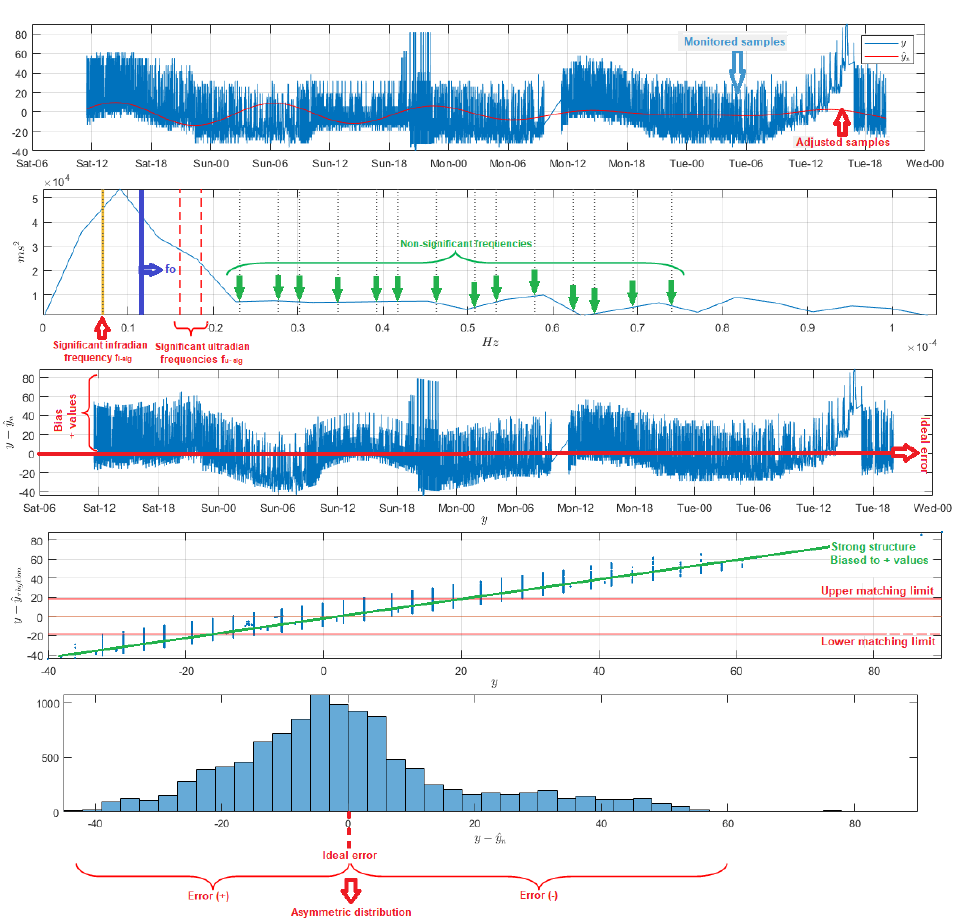
Figure A1. Modeling the CO 2 signal at Sensor Node 4 of DigiMesh network ( Ord = 0, and Reg = 0). From top to bottom: Rhythmometric analysis, frequency components in the FFT, residual time evolution, Bland–Altman diagram, and residual histogram.